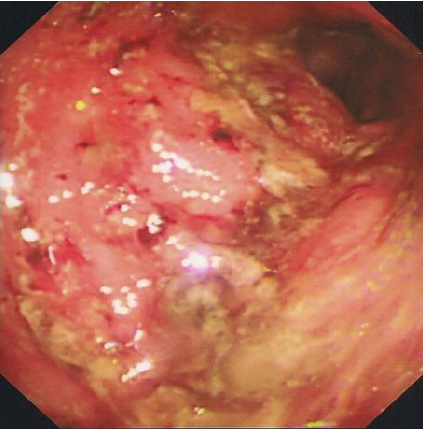
Figure 1: Endoscopic image of the sigmoid colon demonstrating deep ulceration with mucopurulent exudate.